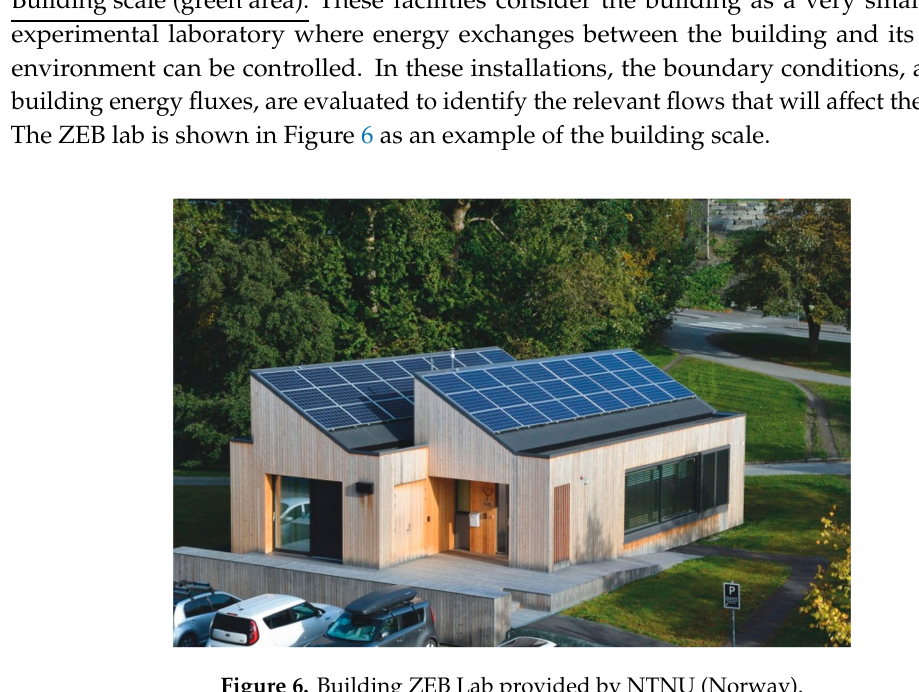
Figure 6. Building ZEB Lab provided by NTNU (Norway).